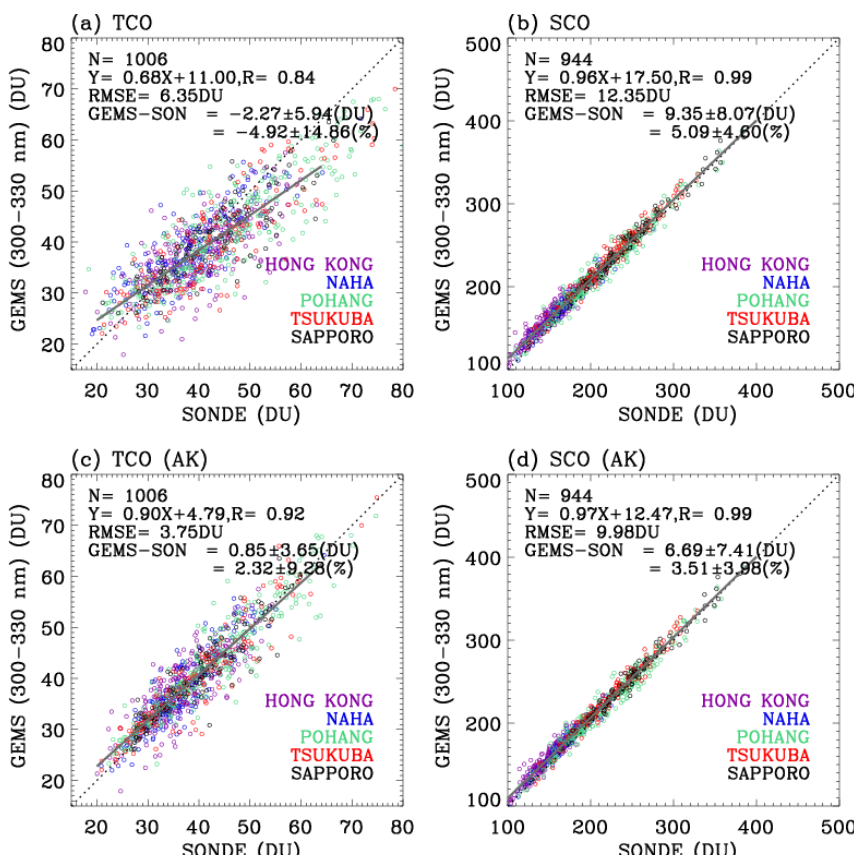
Figure 8. (a, b) Scatter plots of GEMS vs. ozonesonde for tropospheric and stratospheric ozone columns, respectively. Panels (c) and (d) are the same as the upper ones, except that ozonesonde measurements are convolved with GEMS averaging kernels. A linear fit between them is shown in solid lines, with the 1 : 1 lines (dotted lines). The legends show the number of data points ( N ), the slope and intercept of a linear regression, and correlation coefficient ( r ), with mean biases and 1 σ standard deviations for absolute (DU) and relative differences (%), respectively. Note that we use 5 stations identified as a good reference among 10 stations listed in Table 1 in this